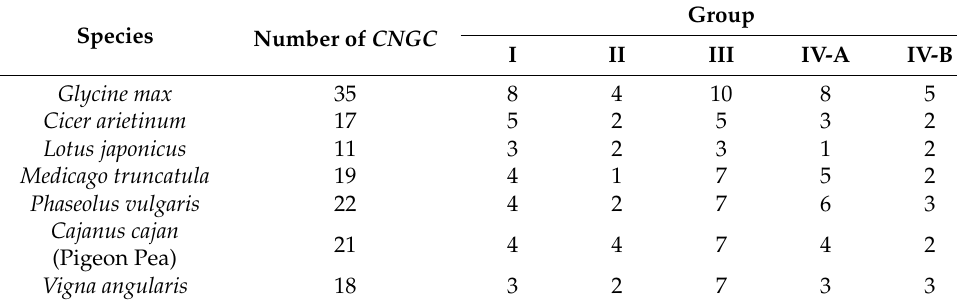
Table 1. Identification and classification of seven leguminous